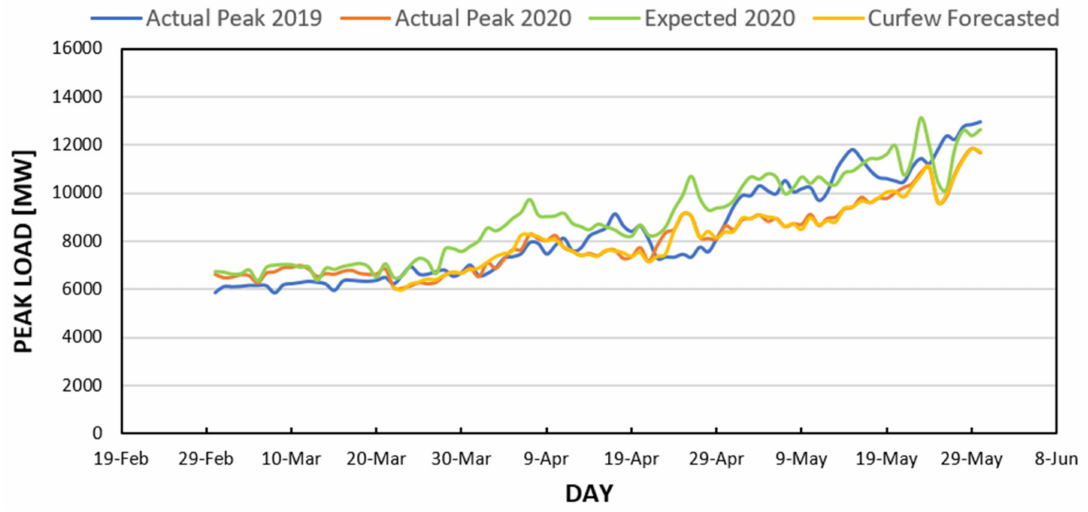
Figure 6. Daily peak load in MW over the test